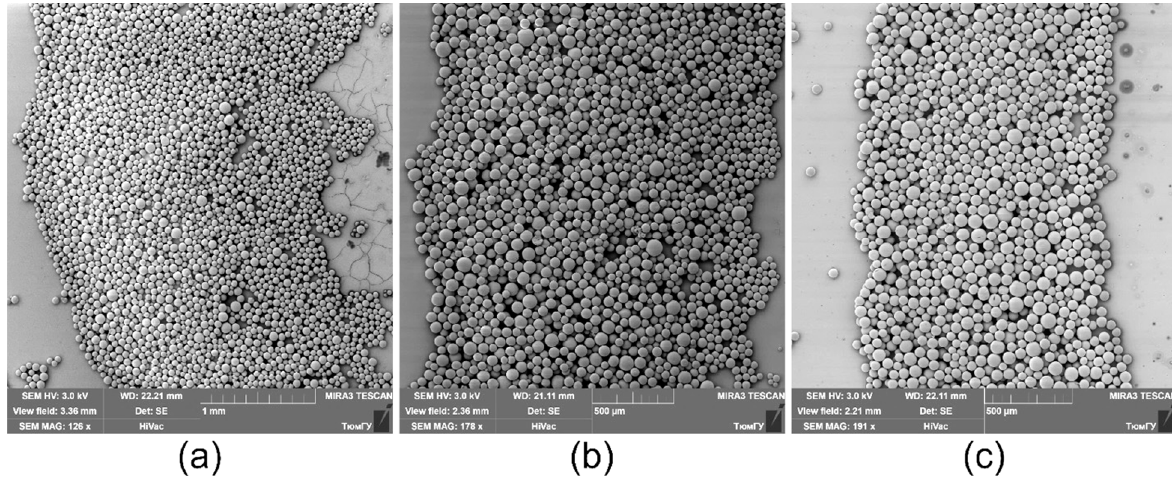
Figure 9. Representative arrangement (distribution) of microparticles within the width of the ring deposit for different values of 𝜏 and 𝑃 : ( a ) 5 s, 5.2 W; ( b ) 5 s, 12 W; ( c ) 15 s, 32 W.